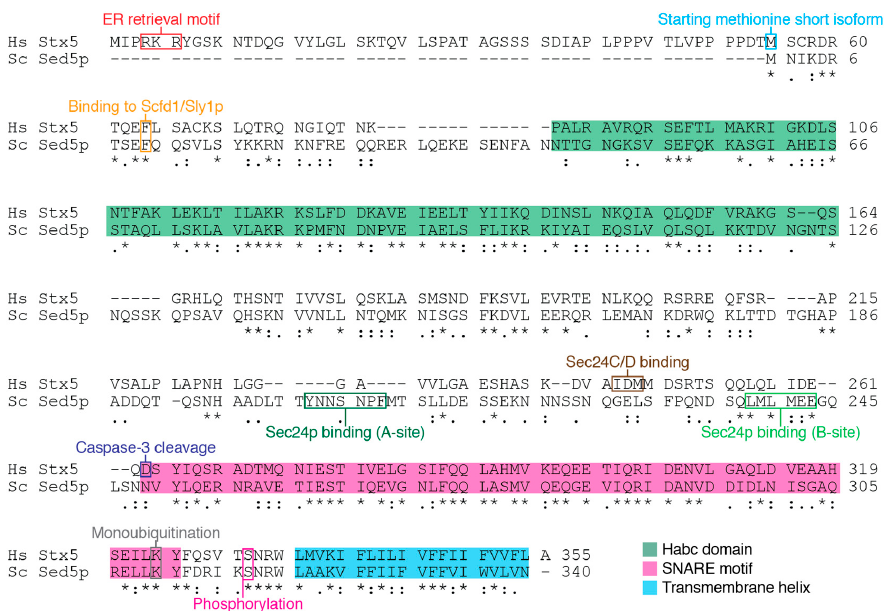
Figure 3. Conserved and distinct interactions of mammalian Stx5 and yeast Sed5p. Alignment of human (Hs) Stx5 and S. cerevisiae (Sc) Sed5p. Indicated are: the double arginine ER retrieval motif of the long isoform of Stx5 [49,57]; the alternative starting methionine of the short isoform of Stx5 [49]; the binding site to Scfd1 (mammals) and Sly1p (yeast) [60,61]; Sec24C/D binding site to the IxM motif of Stx5 [20,62]; Sec24p binding sites to the YNNSNPF motif (A-site) and LxxME motif (B-site) of Sed5p [63]; Caspase-3 cleavage site of Stx5 [64]; monoubiquitination site of Stx5 [65]; phosphorylation site of Sed5p [66].